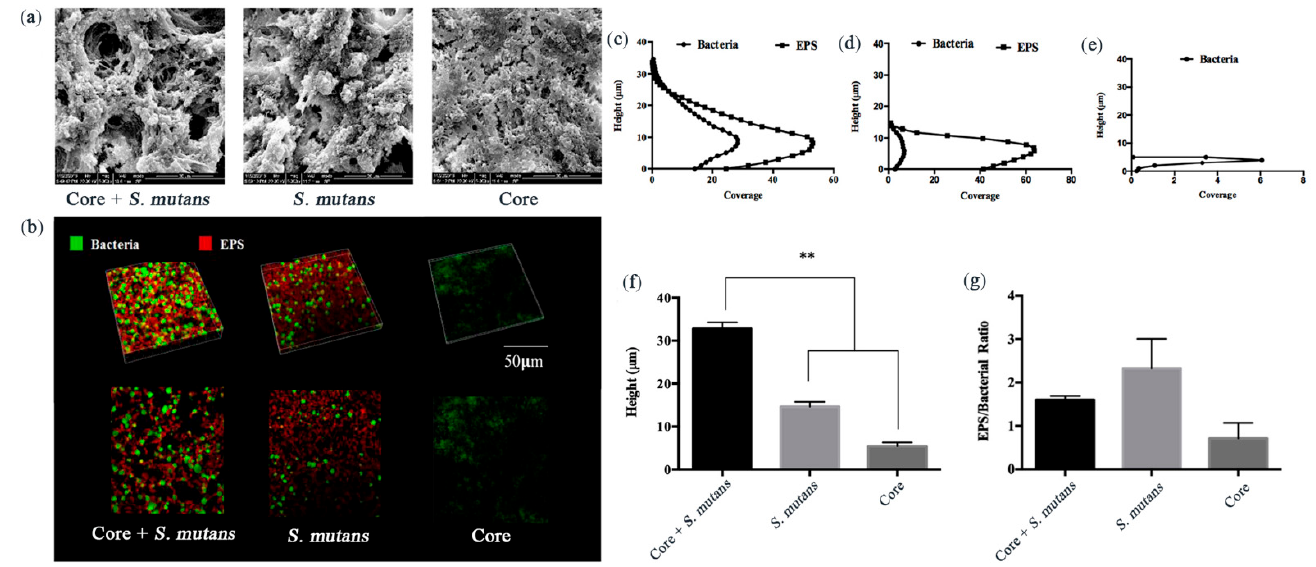
Figure 2. Biofilm structure by SEM and EPS distribution by CLSM. ( a ) Structure of the 72 h Core + S. mutans biofilm, S. mutans biofilm, and the core biofilm (n = 3). ( b ) Double-labeling of 72 h biofilms. Green, bacteria (SYTO 9); red, EPS (Alexa Fluor 647) (n = 3). ( c ) The distributions of EPS and bacteria at different heights of the Core + S. mutans biofilm. ( d ) The distributions of EPS and bacteria at different heights of the S. mutans biofilm. ( e ) The distributions of EPS and bacteria at different heights of the core biofilm. ( f ) The depth of the biofilm. ( g ) Quantification of EPS /bacteria biomass of the 72 h biofilms. ** p < 0.01.